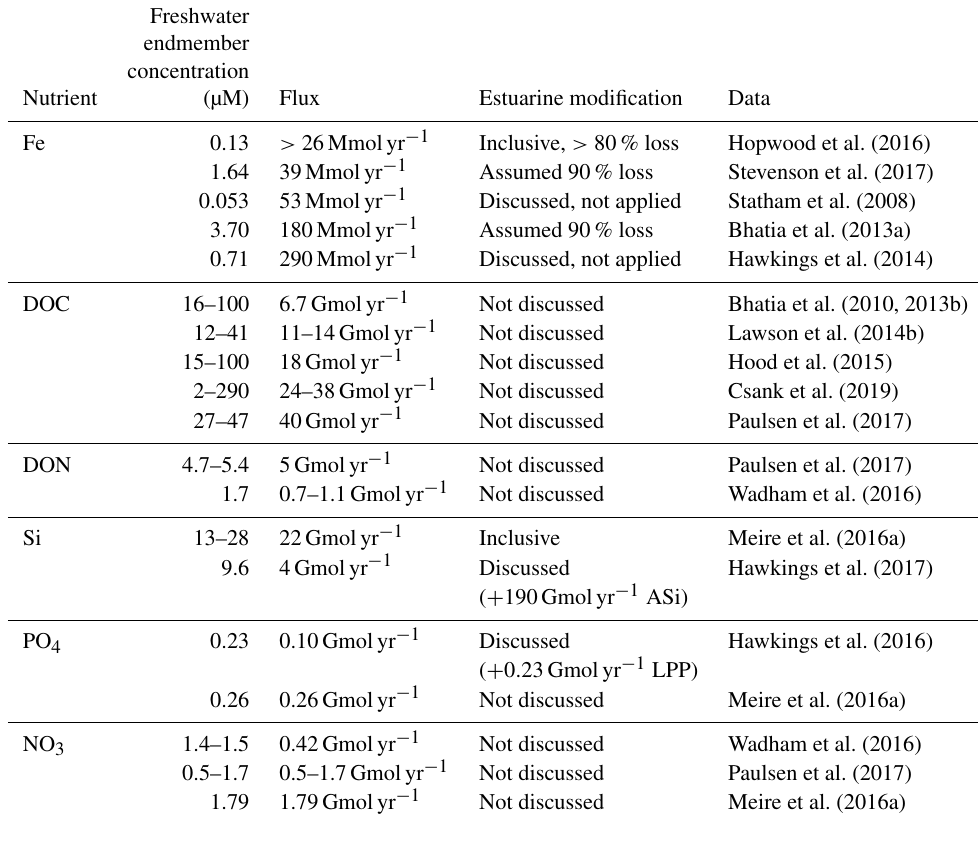
Table 3. Flux calculations for dissolved nutrients (Fe, DOC, DON, NO 3 , PO 4 and Si) from Greenland Ice Sheet discharge. Where a flux was not calculated in the original work, an assumed discharge volume of 1000km 3 yr − 1 is used to derive a flux for comparative purposes (ASi, amorphous silica; LPP, labile particulate phosphorous). For DOM, PO 4 and NO 3 , non-conservative estuarine behaviour is expected to be minor or negligible. Note that whilst we have defined “dissolved” herein as < 0 . 2µm, the sampling and filtration techniques used, particularly in freshwater studies, are not well standardized, and thus some differences may arise between studies accordingly. Clogging of filters in turbid waters reduces the effective filter pore size; DOP, DON, NH 4 and PO 4 concentrations often approach analytical detection limits which, alongside field/analytical blanks, are treated differently; low concentrations of NO 3 , DON, DOP, DOC, NH 4 and DFe are easily inadvertently introduced to samples by contamination, and measured Si concentrations can be significantly lower when samples have been